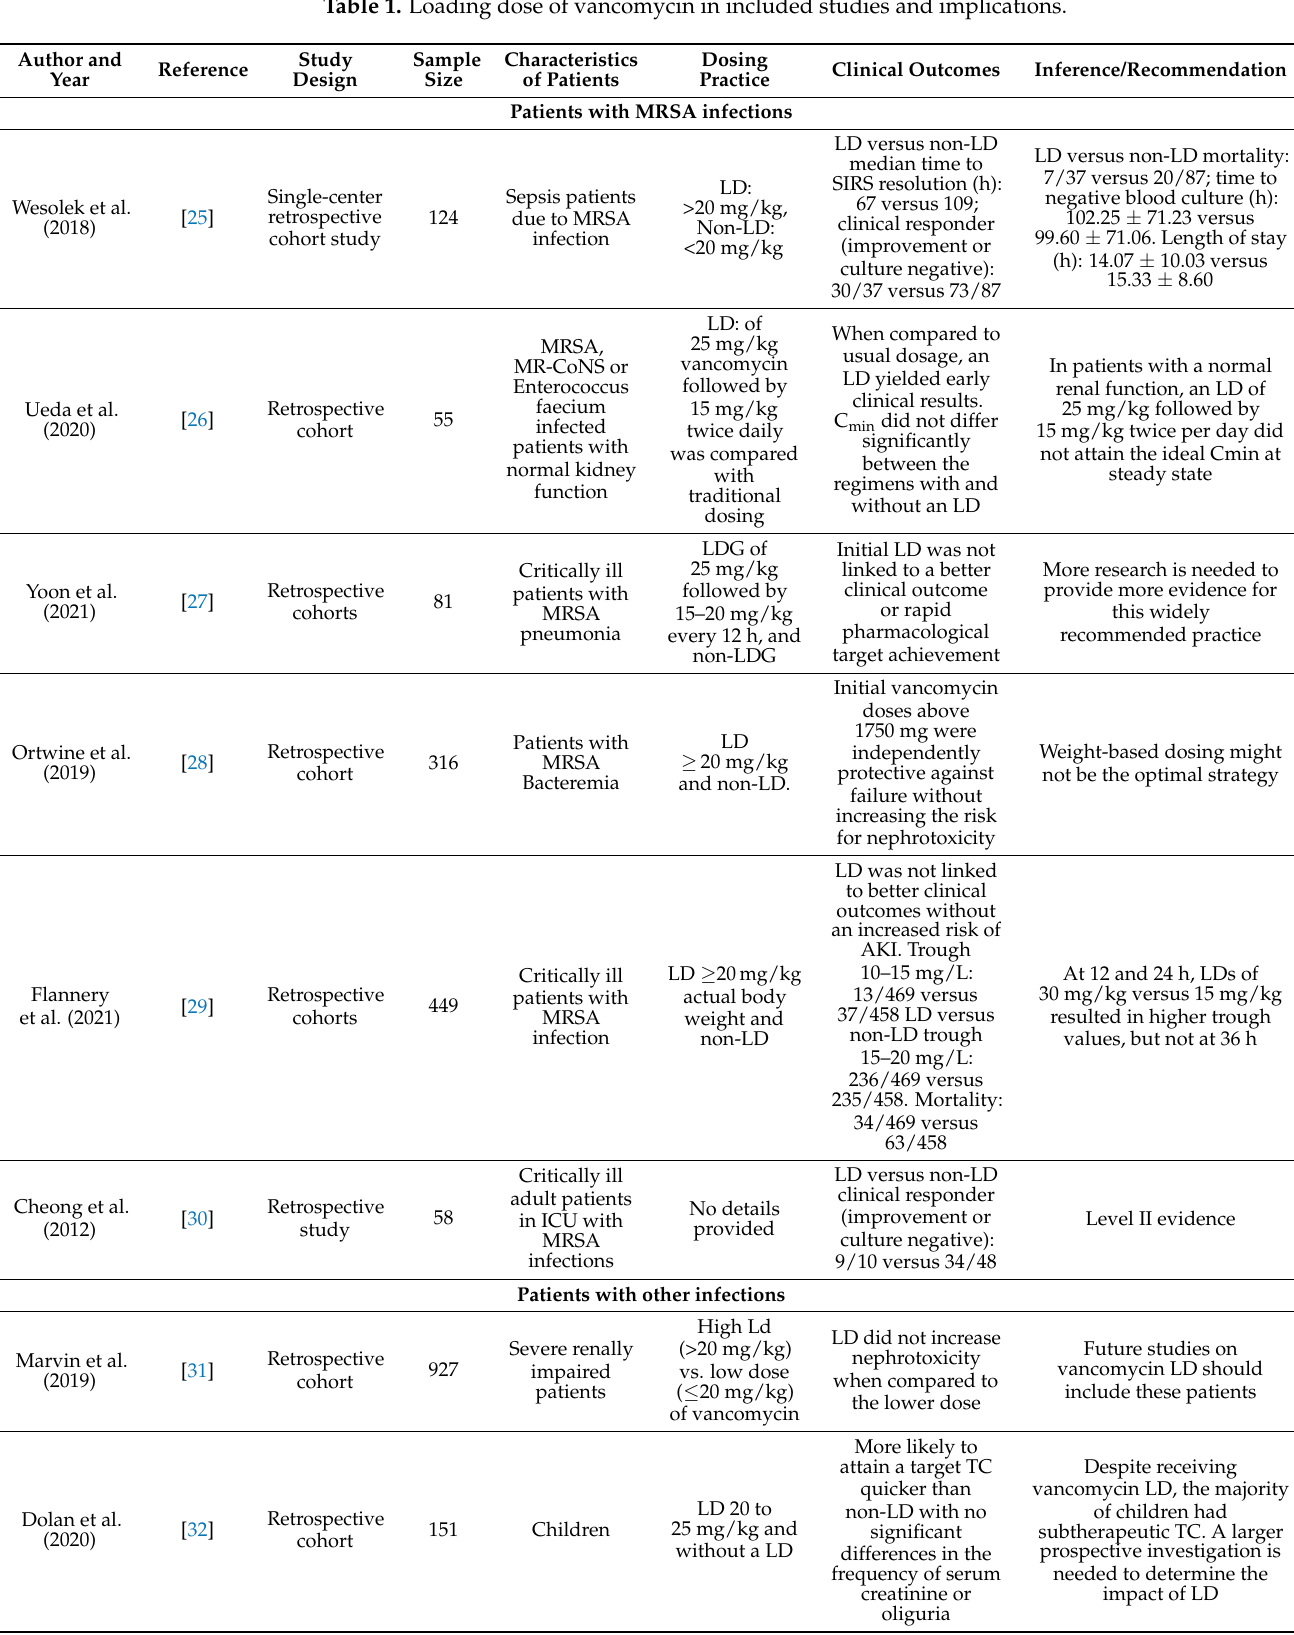
Table 1. Loading dose of vancomycin in included studies and